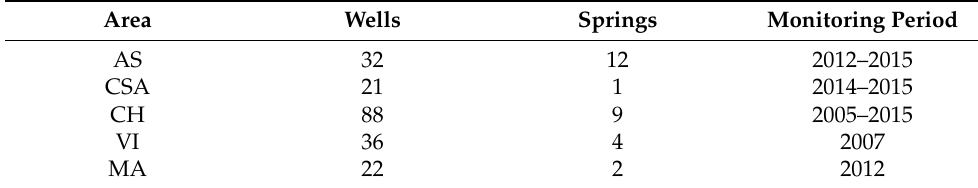
Table 2. Monitored wells and